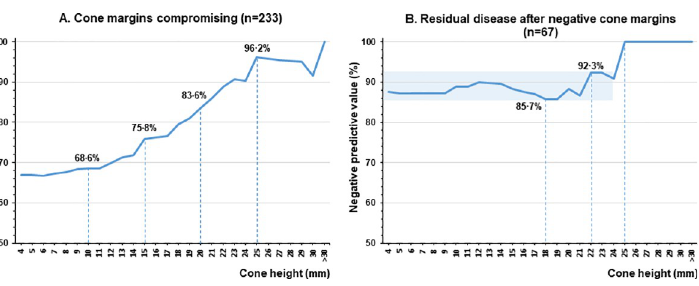
Fig 3. Management of the 244 women aged less than 40 years with squamous cell carcinoma of the cervix stage IA1 according to surgical margins of the first conization specimen, detection of residual disease, and recurrence in the follow-up (6 from 250 cases studied did not have information about conization